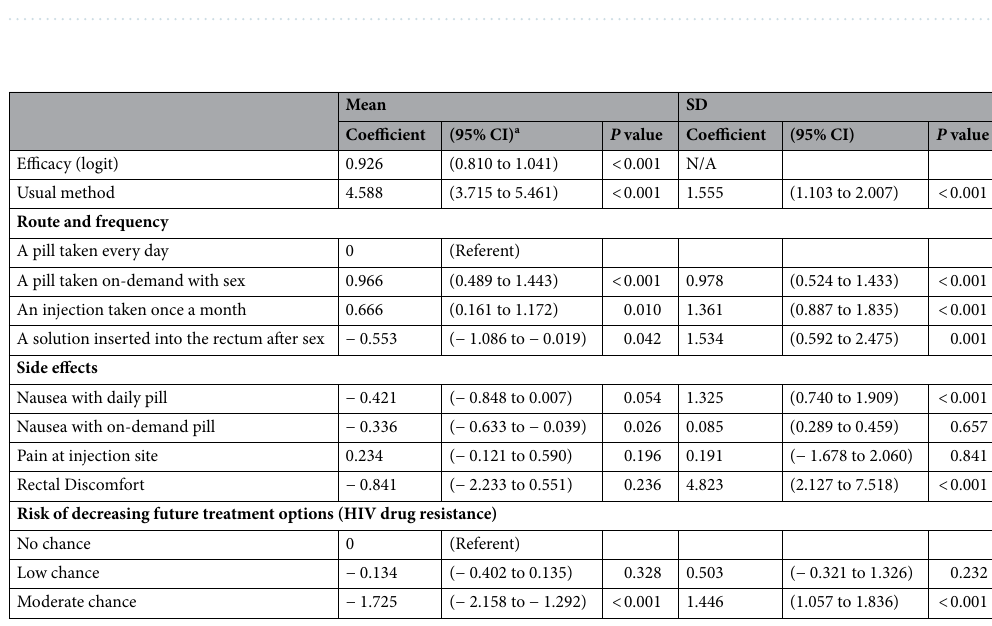
Table 1. Participant characteristics (N = 253). Scale authors proposed that scores of ≥ 10 be used to identify MSM at substantial risk of HIV infection who should be prioritized for PrEP. a The HIV Incidence Risk Index for MSM score is a validated clinimetric scale for quantifying HIV risk in the next 6 months 19 .